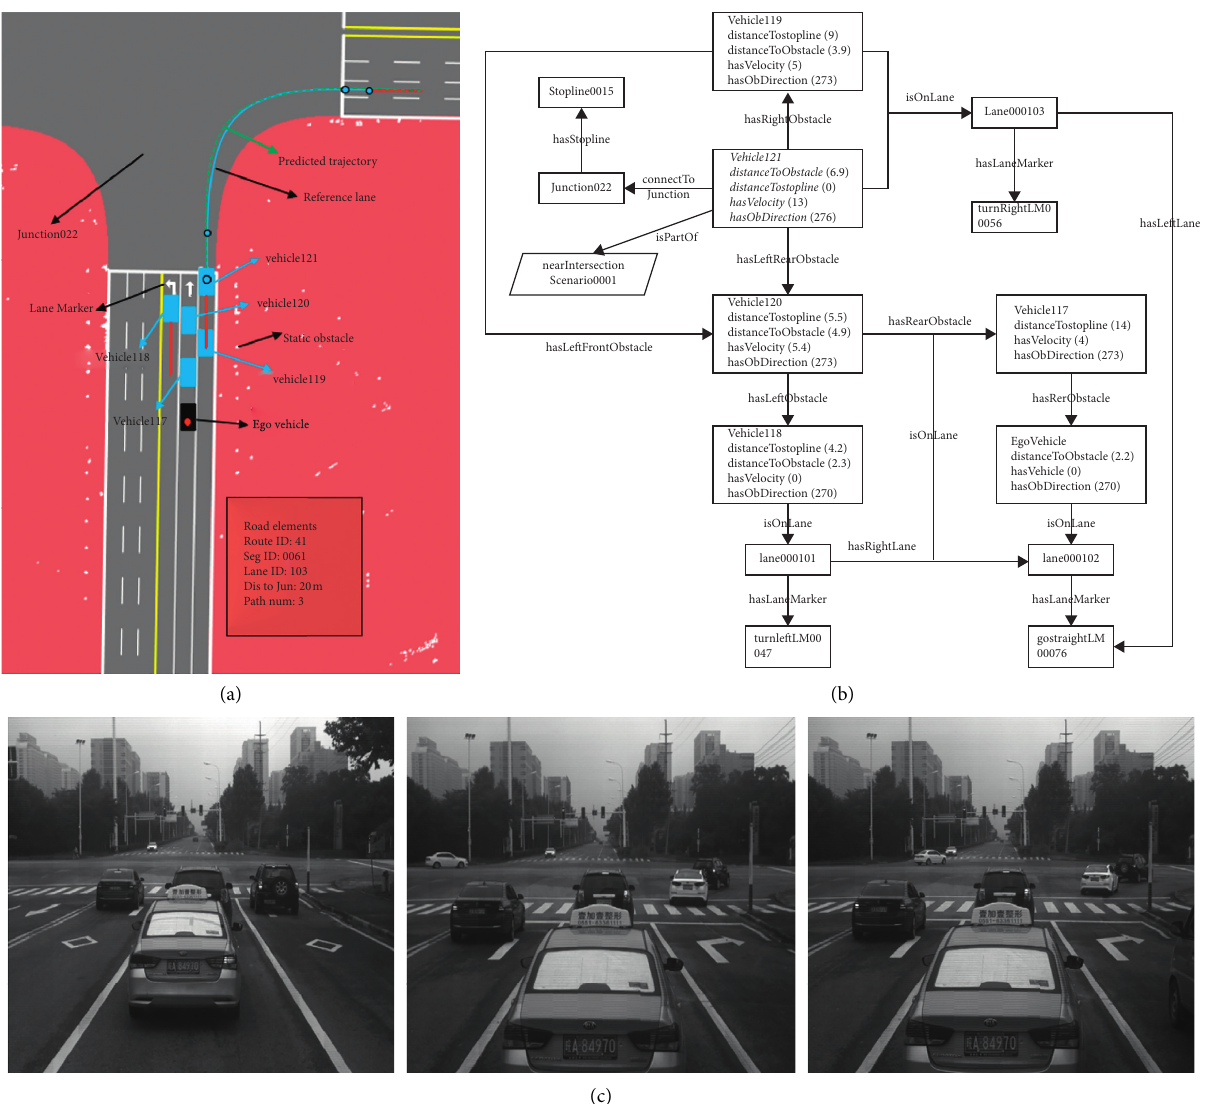
Figure 20: The results for Scenario 2: (a) trajectory prediction interface; (b) scenario reasoning; (c) experimental